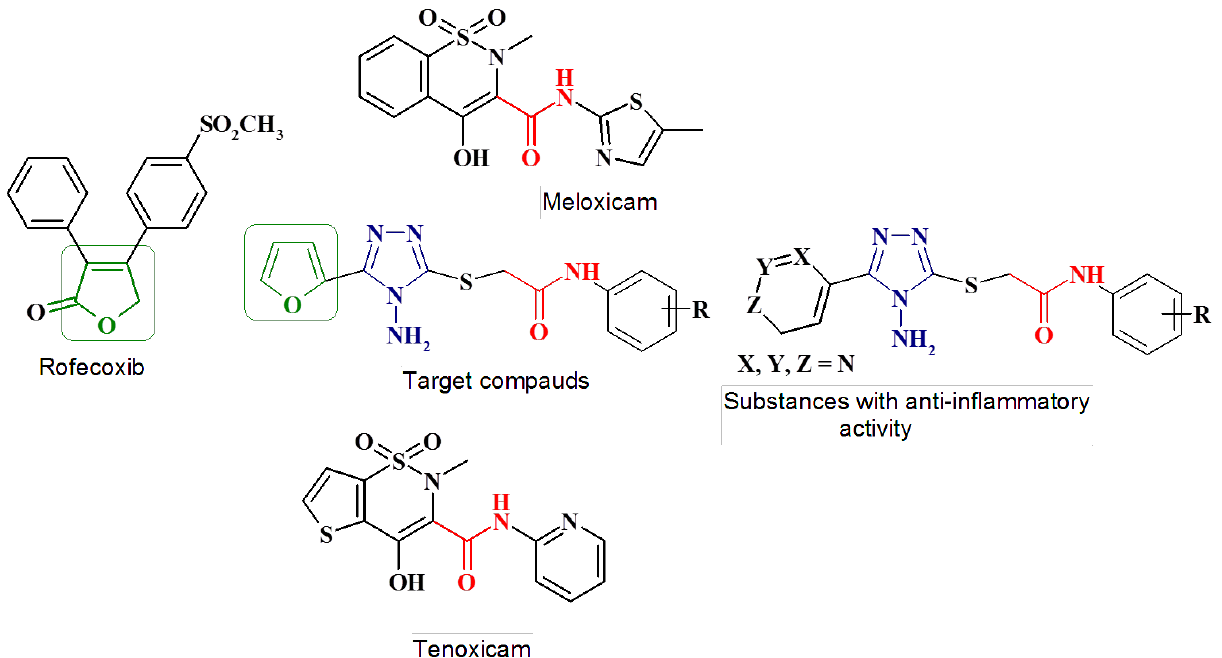
Fig. 1. Structural similarity of the synthesized compounds with known